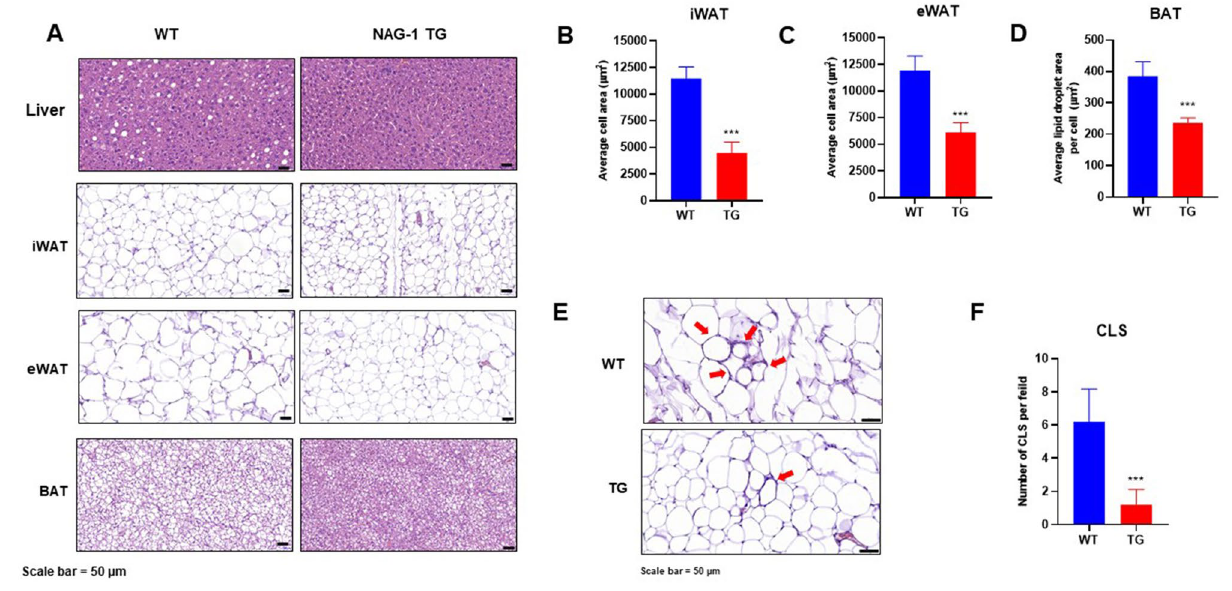
Figure 4. NAG-1 overexpression attenuated high-fat diet/streptozotocin-induced diabetic dyslipidemia and hepatic steatosis in mice. The tissue sections were prepared and stained with hematoxylin and eosin (H&E). ( A ) Representative image of the H&E-stained section of the liver, iWAT, eWAT, and BAT. Scale bar = 50 µm. ( B – D ) Average lipid droplet area in the iWAT, eWAT, and BAT. ( E ) Histological staining of crown-like structure (CLS) in the eWAT. Scale bar = 50 µm. ( F ) Number of CLS per field (10 fields per group). Data are presented as mean ± standard error of mean. *p < 0.05 and ***p < 0.001, compared with the control genes were significantly downregulated in the muscles, iWAT, and BAT of NAG-1 Tg mice. Additionally, the expression level of Ptpn1 , a negative regulator of AKT, was downregulated in the muscles, iWAT, and BAT of NAG-1 Tg mice. Interestingly, the expression level of Mtorc2 was significantly upregulated in the muscles but not in the iWAT and BAT. A previous study reported that Mtorc2 in muscle tissue contributes to glucose homeo- stasis by positively regulating the insulin-stimulated phosphorylation of the Akt substrate As160 and negatively regulating basal glycogen synthase activity 20 . In contrast, Mtorc2 in adipose tissues controls the expression of the lipogenic transcription factor ChREBPβ, which increases de novo lipogenesis in adipose tissue and impairs hepatic insulin sensitivity 21 . The mRNA expression level of Pparg was significantly upregulated in the iWAT and BAT, but not in the muscles. As adipose tissue is the major mediator of PPARγ activity on insulin sensitivity, PPARγ activation in mature adipocytes induces the expression of several genes involved in the insulin signaling cascade and, consequently, enhances insulin sensitivity 22 . Furthermore, the thermogenesis related-genes includ- ing Ucp1, Cidea, Prdm16, and Fgf21 , significantly increased in BAT of NAG-1 Tg mice, indicating that NAG-1 plays roles in thermogenesis (Fig. 6D). To confirming the effect of NAG-1 on insulin signaling at the post-trans- lational level, we performed the western blot. The results indicated that NAG-1 Tg mice showed a significant positive effect on insulin signaling by enhancing phosphorylated IRS (insulin receptor substrate) at Tyr612 and its downstream Akt by increasing phosphorylation of Akt at ser473 (Fig. 6E). Effect of NAG‑1 overexpression on the mRNA expression levels of adipocytokines. Adiponec- tin and leptin, major adipokines, are important mediators of energy homeostasis. Leptin decreases appetite, stimulates thermogenesis, enhances fatty acid oxidation, decreases glucose levels, and reduces body weight and fat mass 23 . The effect of NAG-1 overexpression on the mRNA expression levels of adiponectin and leptin was examined in NAG-1 Tg mice. The mRNA level of adiponectin was upregulated, whereas that of leptin was down- regulated, in the muscles and iWAT of NAG-1 Tg mice. However, the mRNA level of adiponectin in BAT was not significantly different between WT and NAG-1 Tg mice (Fig. 7). Effect of NAG‑1 overexpression on the mRNA expression level of NLRP3 inflammasome com‑ ponents.